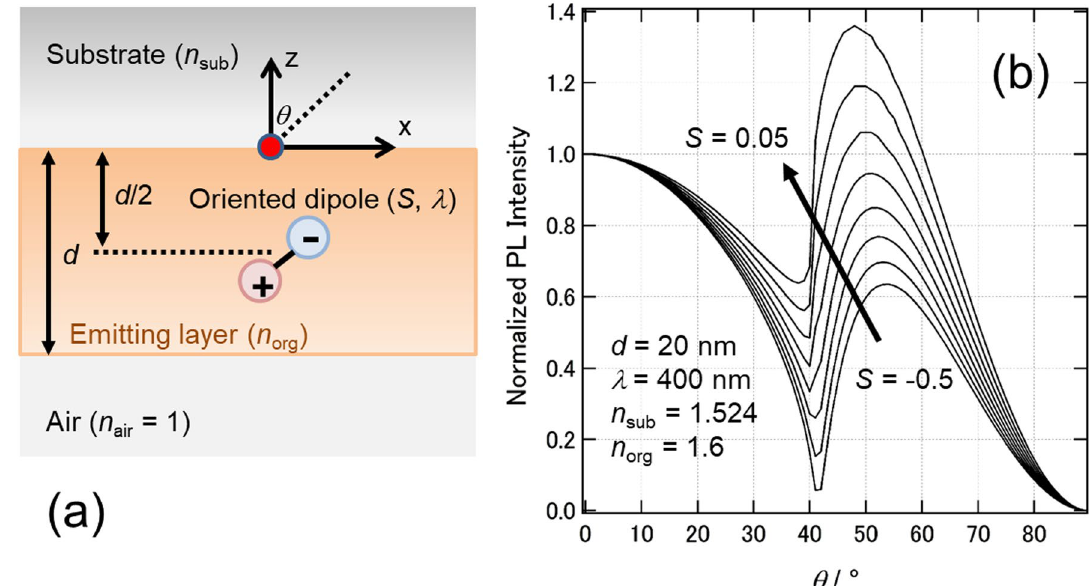
Figure 1. ( a ) Schematic model of the photonic mode simulation. ( b ) Simulation result for d = 20 nm, = 1.524, and n = λ = 400 nm, n sub org